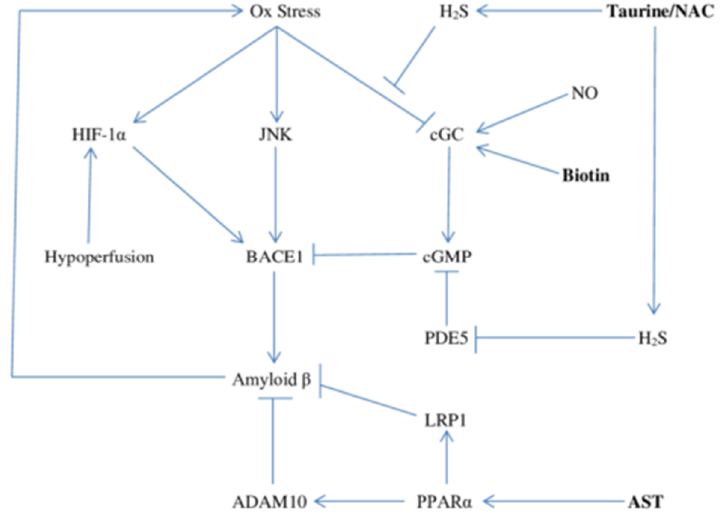
Figure 2. Modulation of BACE1 and ADAM10 expression and consequent amyloid β production by oxidative stress, hypoperfusion, determinants of cGMP production, and PPARα agonism. Nutraceutical measures which support or mimic NO bioactivity (biotin), promote H 2 S biosynthesis (taurine/NAC), and activate PPARα (AST) may down-regulate amyloid β synthesis.